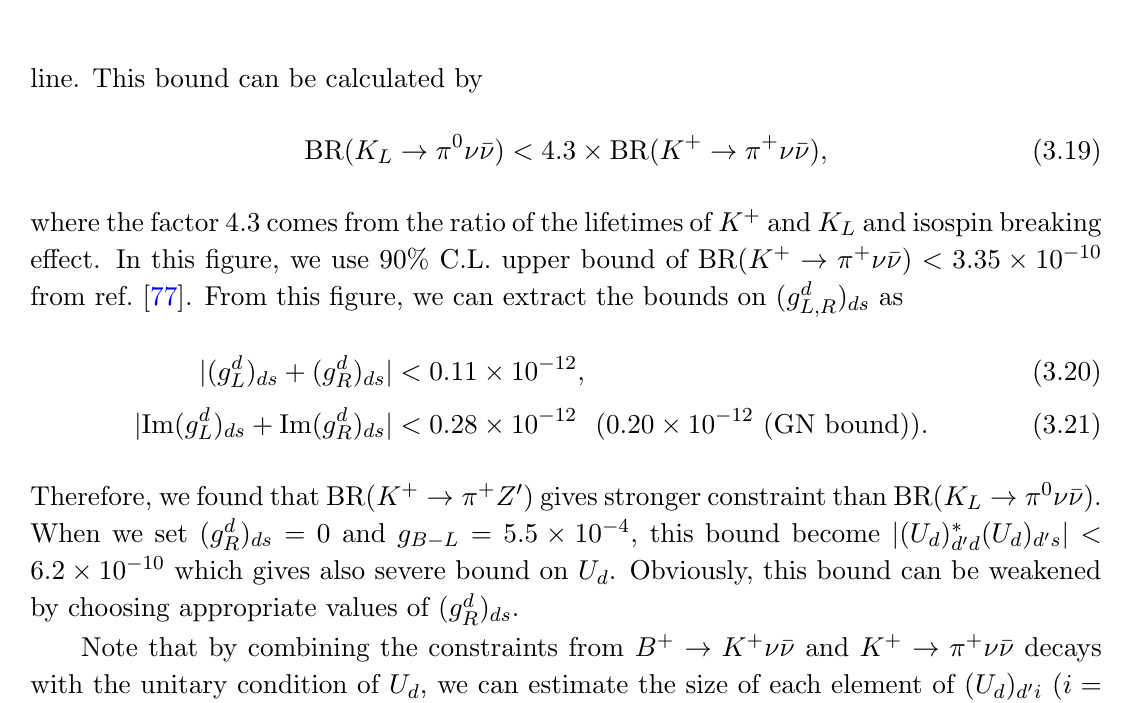
Figure 4 . The red curve in each panel shows our prediction of BR( K + ! (cid:25) + Z 0 ) (left) and BR( K L ! (cid:25) 0 (cid:23) (cid:22) (cid:23) ) (right) with M Z 0 = 30 MeV. The black solid lines in each panel show the upper bound from BR( K + ! (cid:25) + Z 0 ) exp (eq. (3.16)) and BR( K L ! (cid:25) 0 (cid:23) (cid:22) (cid:23) ) exp (eq. (3.17)). In the right panel, the green line shows the Grossman-Nir bound